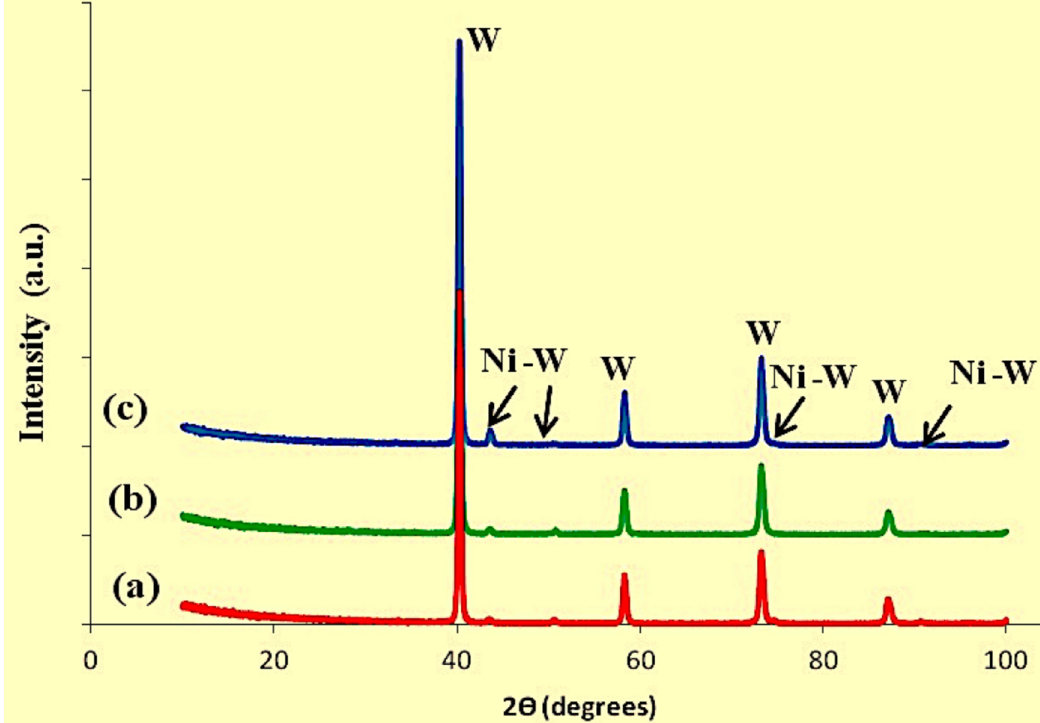
Figure 4. XRD patterns of the obtained ODS tungsten heavy alloys sintered materials, where: ( a ) W-Ni-Fe-Co-TiO 2 (sample no. three), ( b ) W-Ni-Fe- ZrO 2 (sample no. six) and ( c ) W-Ni-Co- Y 2 O 3 (sample no. nine).